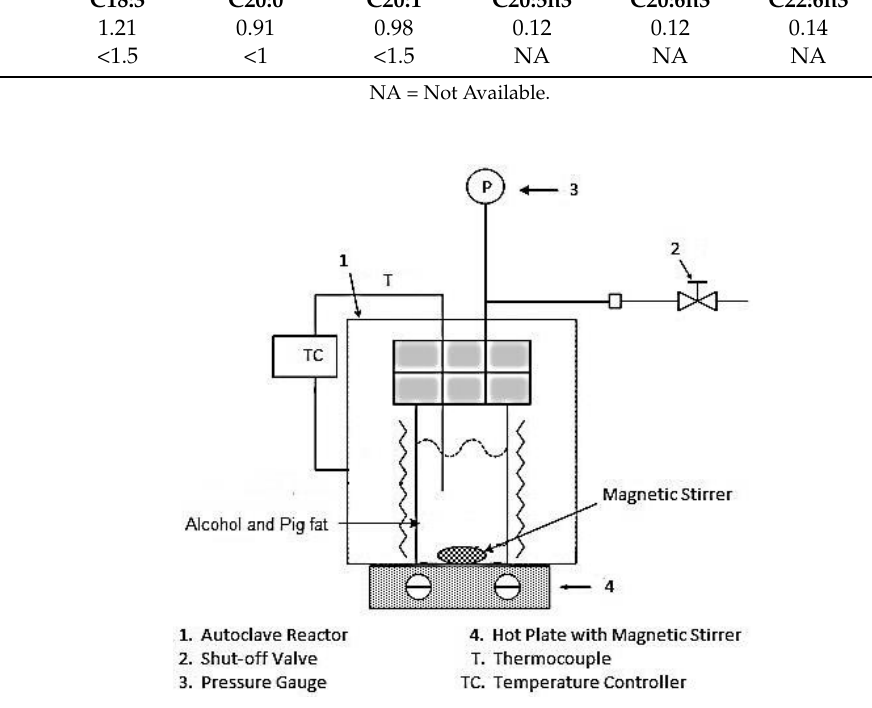
Figure 1. Schematic diagram of the experimental apparatus.